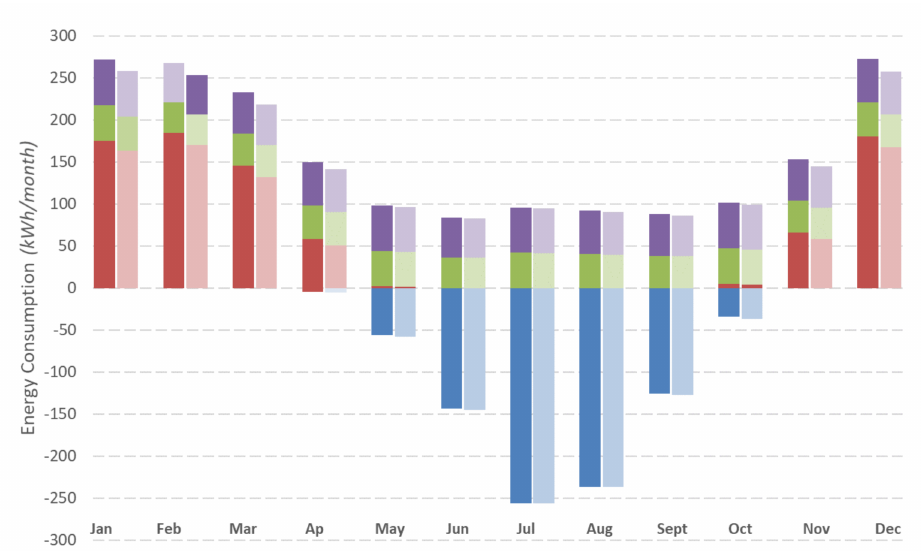
Figure 9. Energy needs before (scenario 0) and after (scenario 1) the ventilated façade in the Voula demo site.